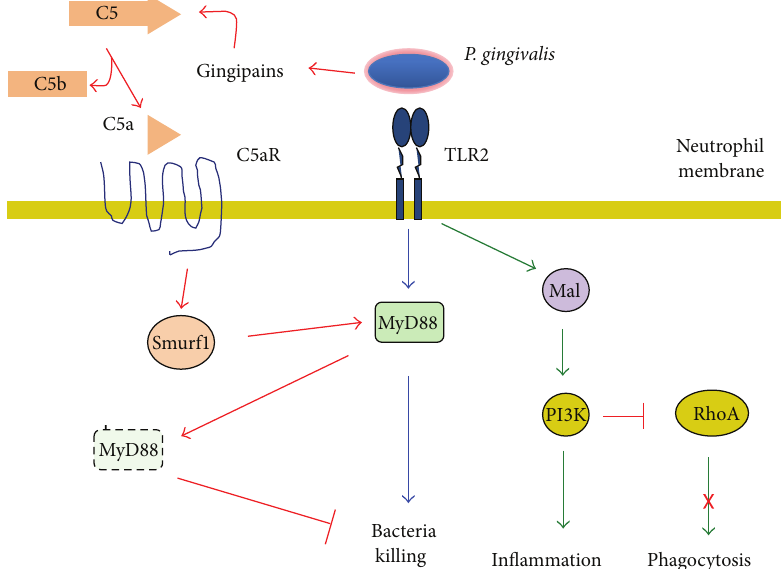
Figure 3: P. gingivalis can manipulate both complement and TLR signaling to induce bacterial persistence . The bacterium P. gingivalis is recognized by the TLR2 on neutrophils and activates the adaptor protein MyD88 for bacterial elimination (blue arrows). However, P. gingivalis produce gingipains, enzymes that function as complement C5 convertases. C5a complement fragment binds to its receptor (C5aR), which induces the E3 ligase Smurf1 to ubiquitinate MyD88 and mark if for proteosomal degradation (red arrows), effectively inhibiting bacteria killing. Interestingly, binding of P. gingivalis to the TLR2 also induces inflammation through a signaling pathway involving the adaptor moleculeMalandtheenzymephosphatidylinositol3-kinase(PI-3K)(greenarrows).Also,thesamepathwaycanpreventactinpolymerization through inhibition of the small GTPase RhoA and block